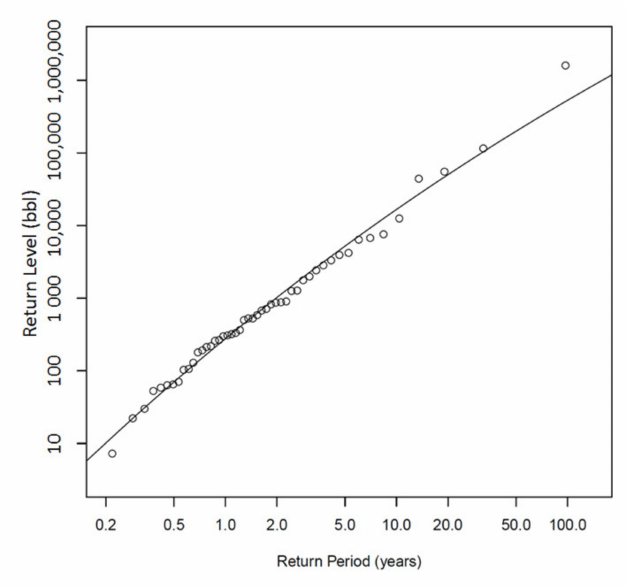
Figure 2. Return levels (spill volume) under different return periods. The dots are calculated based on the observations, and the curve is from the generalized extreme value (GEV) distribution calculated using the maximum-likelihood method with the R software